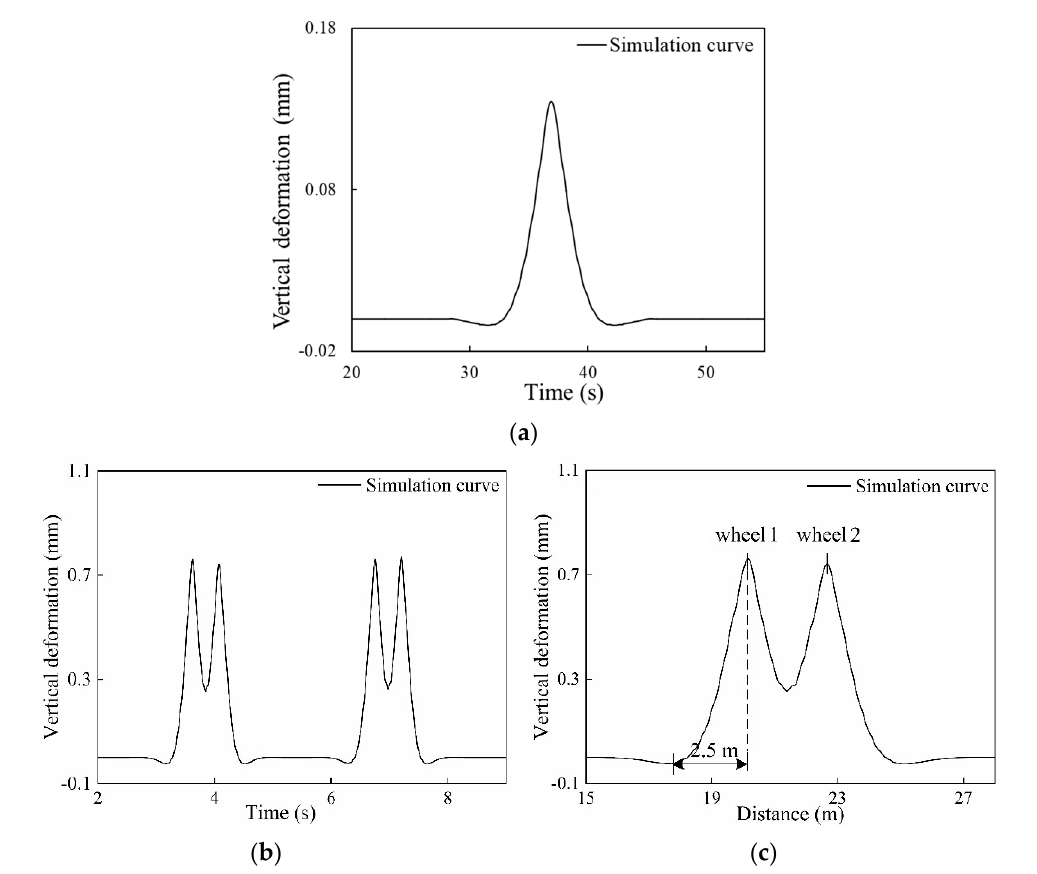
Figure 7. The response curve of the rail vertical displacement: ( a ) The vertical displacement response curve of the rail under the action of the wheel at 0.4 m/s; ( b ) The vertical displacement response curve of the rail under the action of the vehicle at 20 km/h; ( c ) The vertical displacement response curve of the rail under the action of the bogie at 20 km/h.